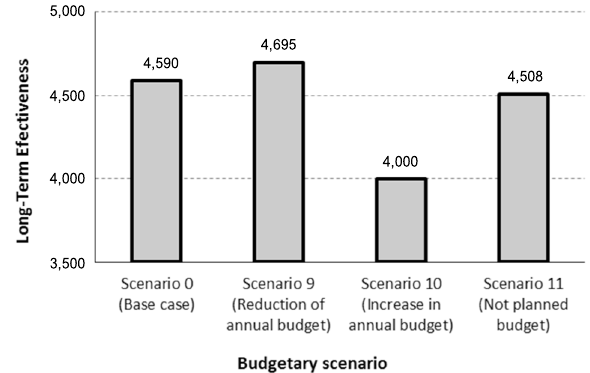
Fig. 7. Variation of LTE with different distribution of funds over